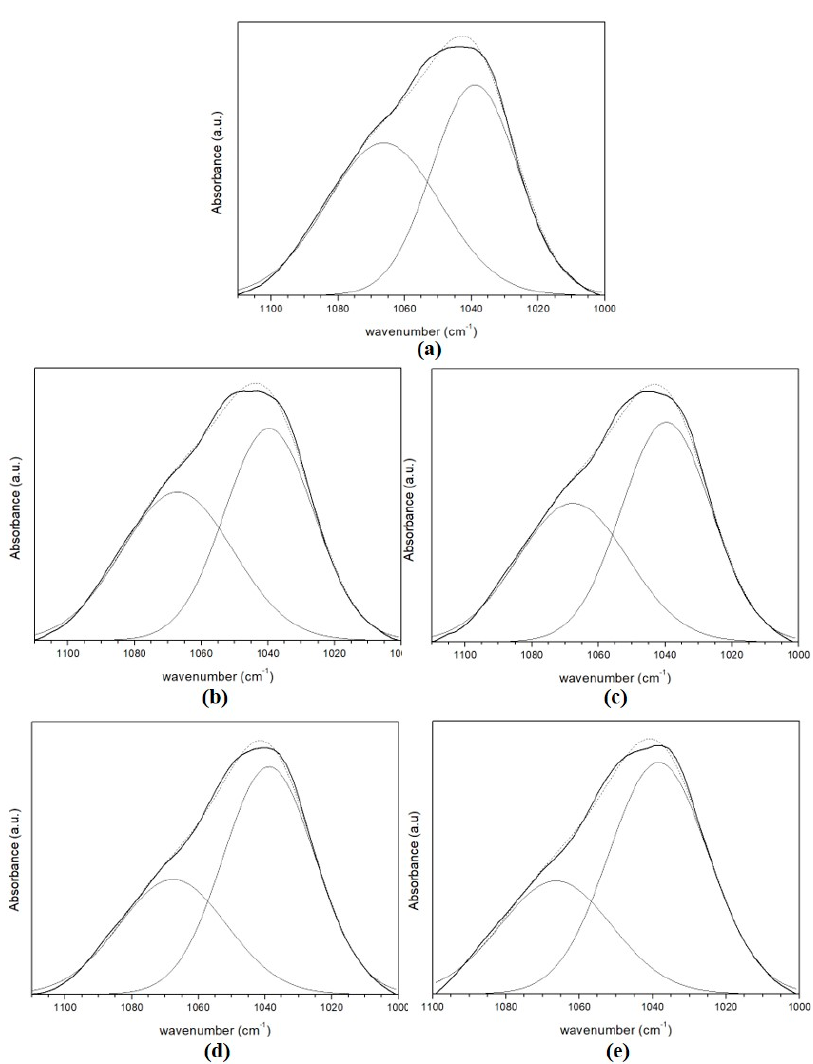
Figure 6. ATR-FTIR spectra of the hybrid membranes from series 1 in the 1000–1110 cm − 1 region. Curve-fitting decomposition of the bands located between 1000 and 1110 cm − 1 for: ( a ) CA / SiO 2 (95 / 5); ( b ) CA / SiO 2 / TiO 2 (95 / 4.5 / 0.5); ( c ) CA / SiO 2 / TiO 2 (95 / 4 / 1); ( d ) CA / SiO 2 / TiO 2 95 / 3 / 2, and ( e ) CA / SiO 2 / TiO 2 95 / 2 / 3 membranes. Bold black line—experimental results; dashed line—simulated results. Table 3. Assignments of the ATR-FTIR spectra of the CA / SiO 2 / TiO 2 (series 1) membranes. Table 5. Summary of the spectral deconvolution in the 1000–1110 cm − 1 region in series 1 (CA/SiO 2 /TiO 2 ).